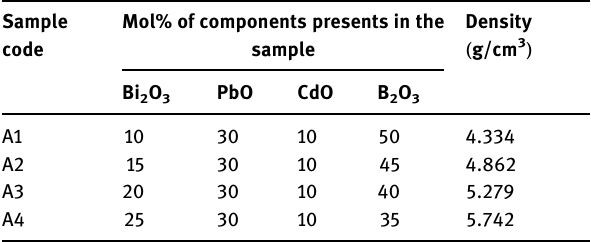
Table 1: Composition and density of samples Sample Mol% of components presents in code